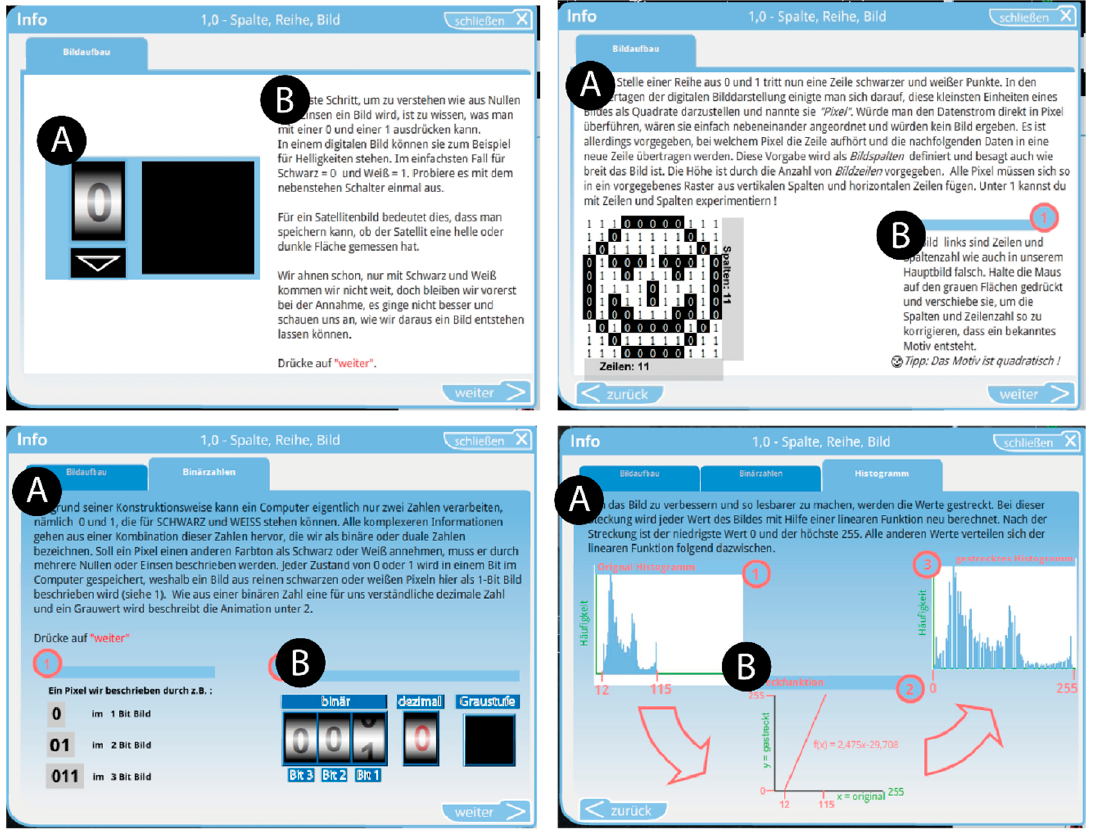
Figure 10. Refined use of the “Coherence Principle”. ( A ) Interaction / Animation; ( B ) Text (Source: see Appendix